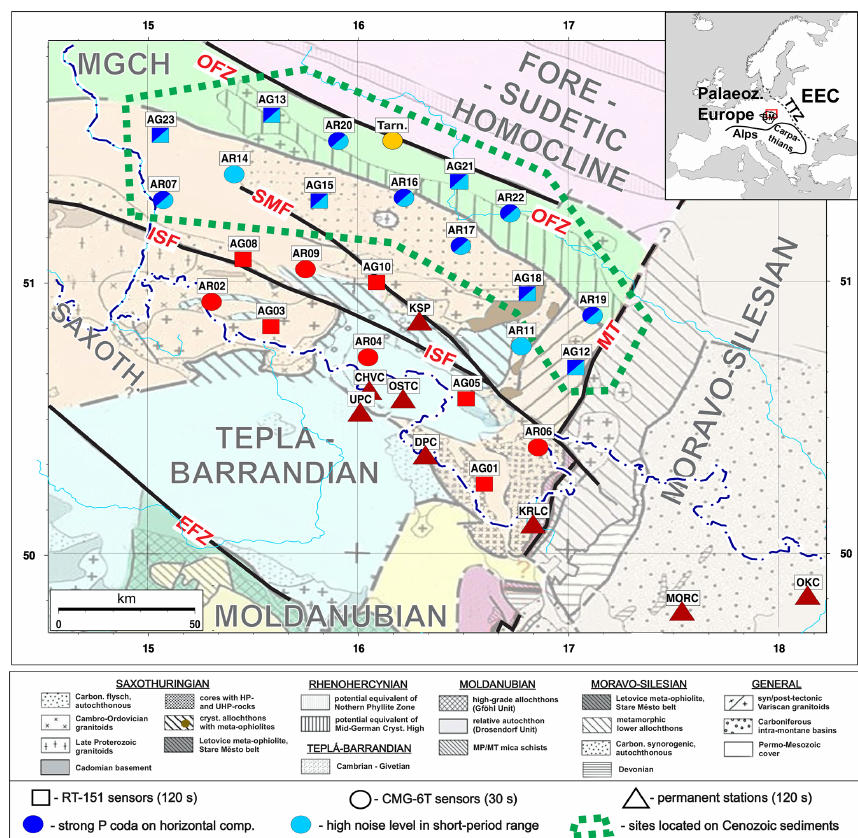
Figure 2. Locations of temporary (circles and squares) and permanent (triangles) stations used in the experiment on a background of a tectonic map (modified after Franke et al., 2017). BM – Bohemian Massif, EEC – East European Craton, EFZ – Elbe Fault Zone, ISF – Intra-Sudetic Fault, MGCH – Mid-German Crystalline High, MT – Moldanubian Thrust, OFZ – Odra Fault Zone, SMF – Sudetic Marginal Fault, TTZ – Teisseyre–Tornquist Zone. The dotted green line delimits area where observation sites are located on Cenozoic sediments. Other stations are mostly located on Palaeozoic or Proterozoic basement, and two stations are on Cretaceous rocks. Light blue marks – stations with high noise amplitude in the short-period range; dark blue marks – stations showing high amplitude, long coda of the P phase on horizontal components (see Sect. 3.1). Yellow circle – location of station in Tarnówek (Mendecki et al., 2016), discussed in Sect.